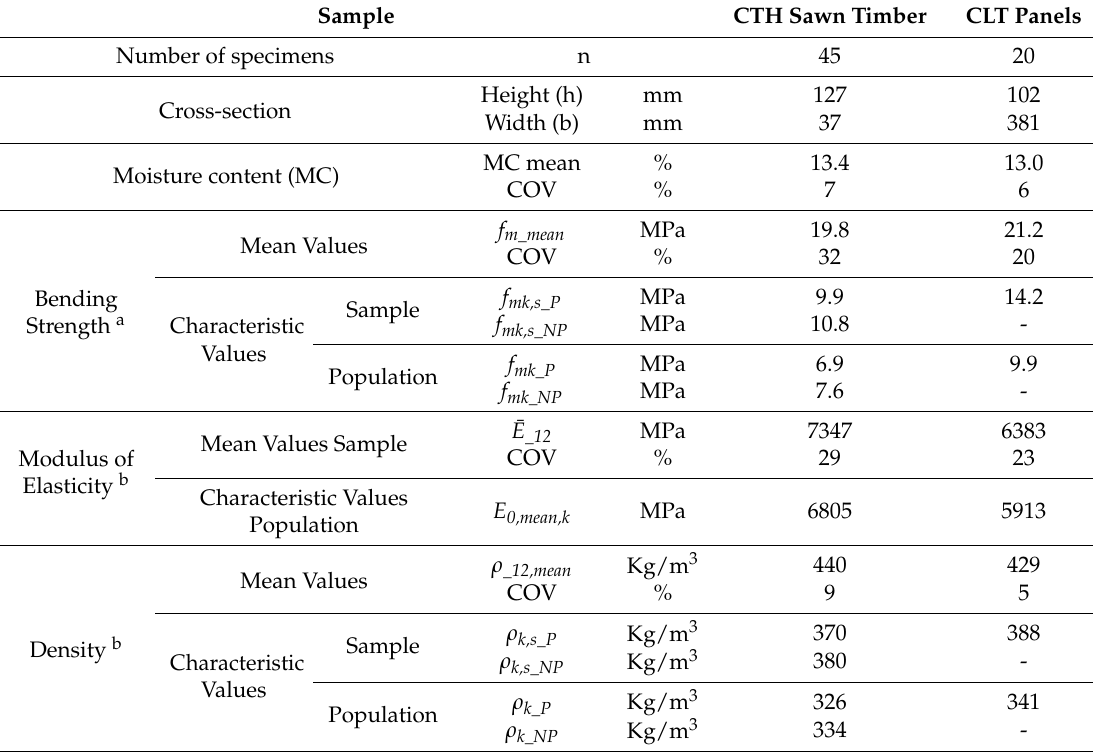
Table 1. Bending properties and density of the CTH sawn timber and the CLT panels. CTH is the newly proposed visual grade.